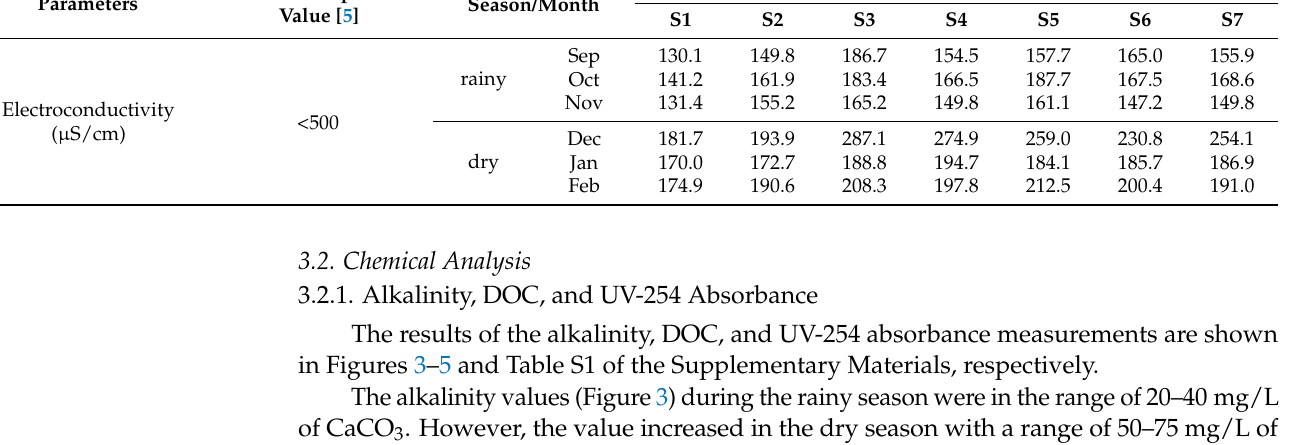
Figure 4. DOC of water at each sampling point.